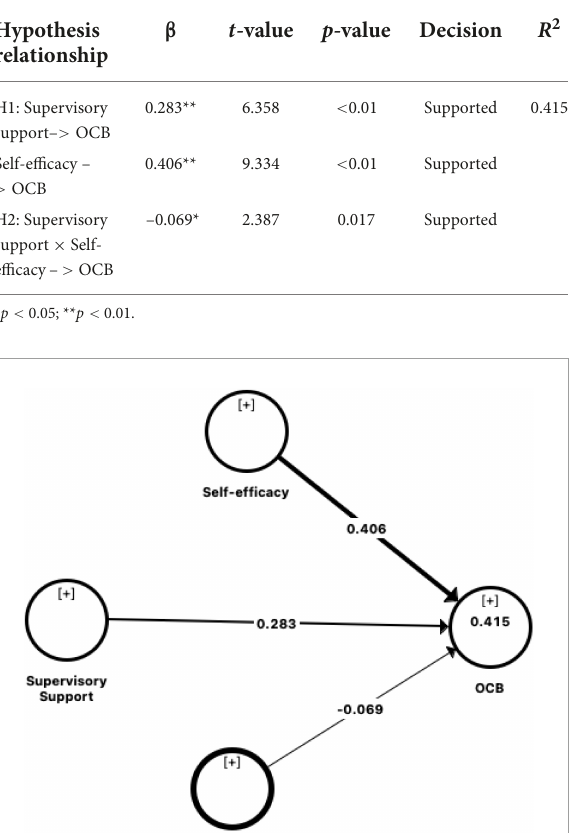
FIGURE2 Structural model.